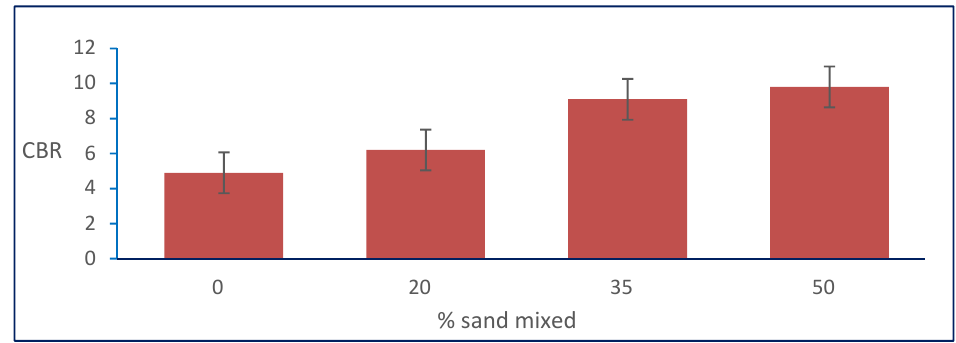
Figure 12. Effect of sand on CBR.